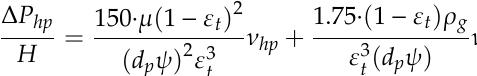
2 ) following over time at 8